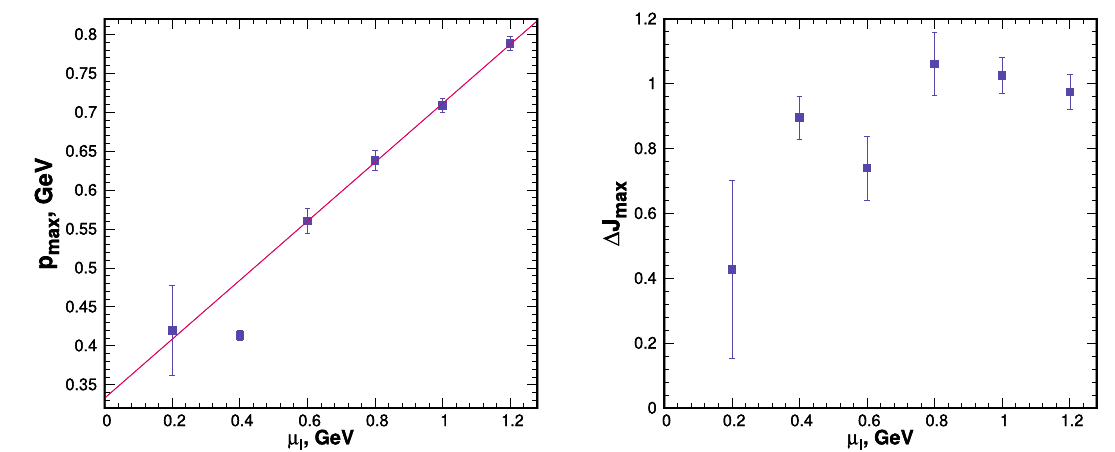
Fig. 10 Dependence of the position (left panel) and the height (right panel) of the peak of (cid:12) J ( p ) on the isospin chemical potential